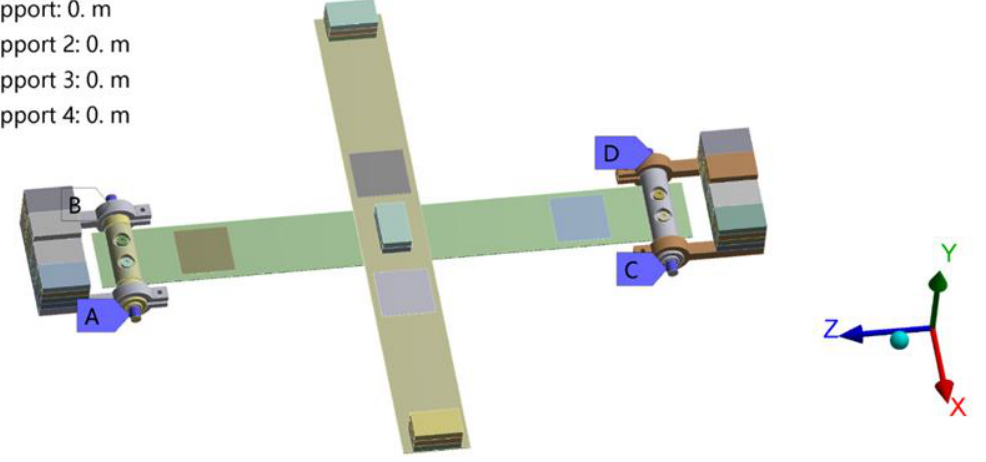
Figure 3. The simulation model of the energy harvester and its constraints.